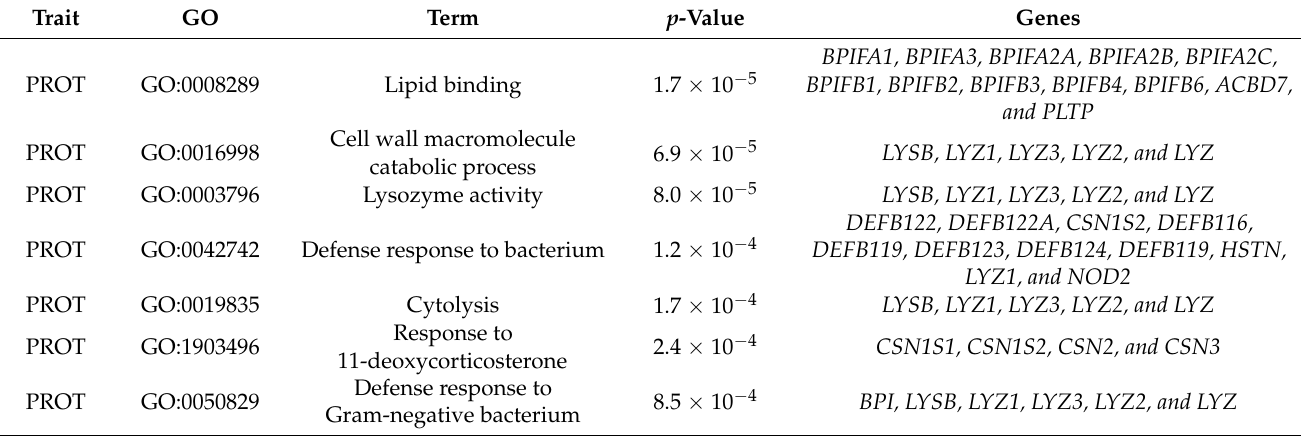
Table 5. Most significantly enriched gene ontology (GO) terms of candidate genes for protein yield (PROT), protein percentage (PROT%), and lactation persistency (LP) in North American Holstein